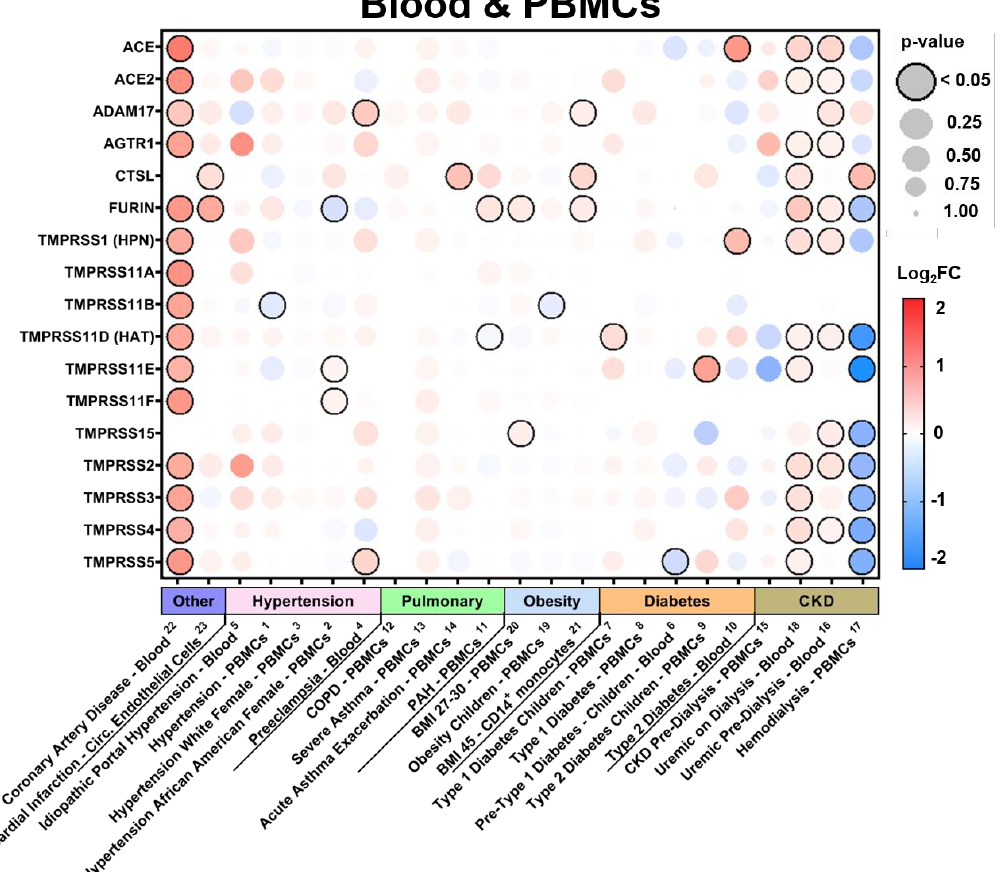
Figure 5. SARS-CoV-2 viral-entry gene expression in blood tissues across comorbidities. Expression of select SARS-CoV-2 viral-entry genes in blood tissues across 23 DataSets representing various common comorbidities. Values are displayed as logarithm to base 2 of the fold change (log 2 FC) in comparison with respective unaffected control samples from each DataSet. Comorbidity groups and each DataSet within are sorted from greatest ( left ) to least ( right ) expression of ACE2. Heatmap coloration is set to a scale of − 2 (blue)to2(red)andvaluesbeyondthisrangeareshownaseither − 2or2, respectively. Statisticalsignificance is represented proportional to dot size where largest dot size indicates highest statistical significance as indicated in the key and a black border designates p < 0.05. Superscript numbers link each DataSet to additional information found in Appendix A and Supplementary File 1. BMI = body mass index; CKD = chronic kidney disease; COPD = chronic obstructive pulmonary disease; PBMCs = peripheral blood mononuclear cells; PAH = pulmonary arterial